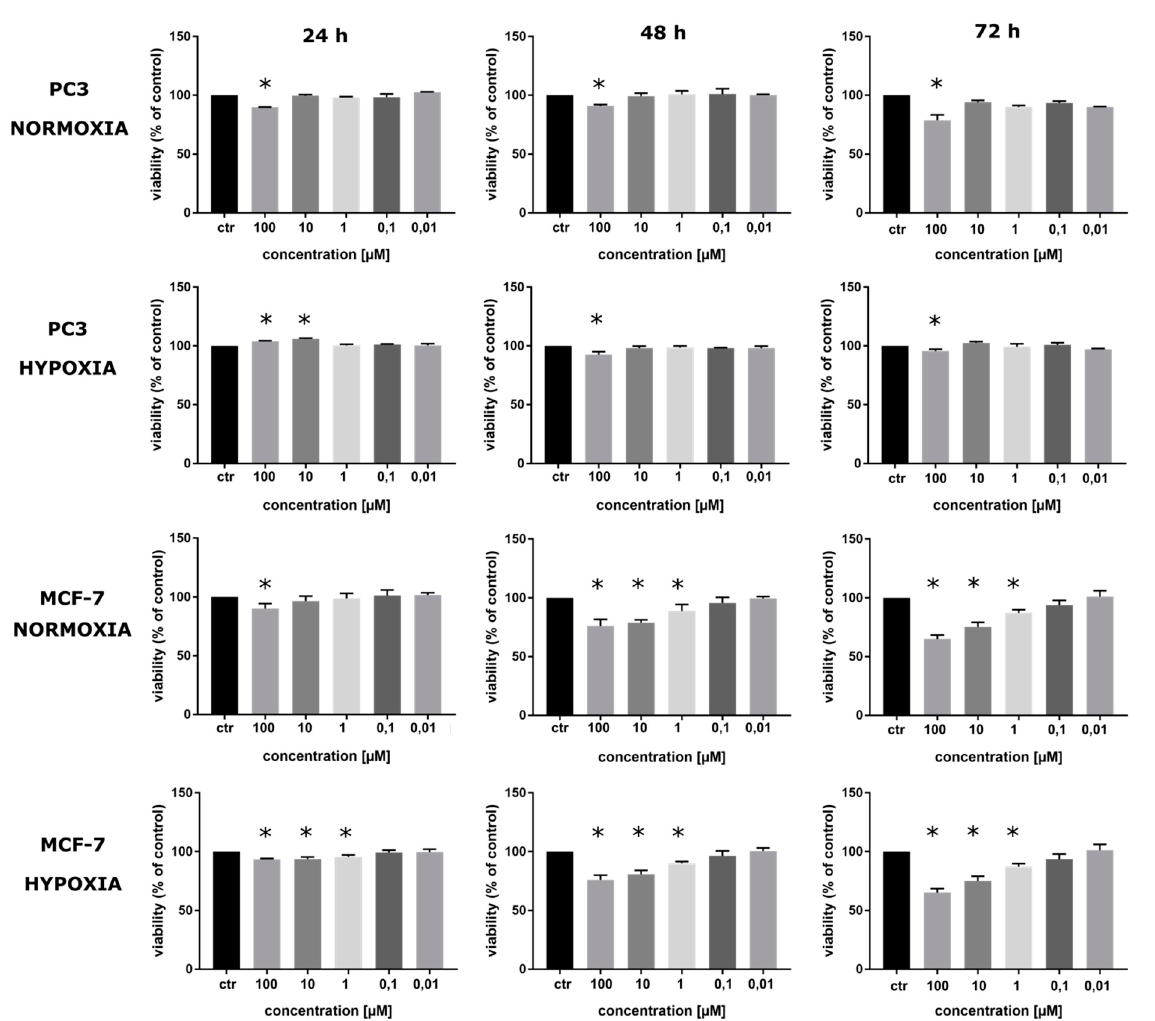
Figure 2. The viability of MCF-7 and PC3 cells after 24, 48 and 72 h treatment with BrdU in a range of concentrations from 0 to 100 µM under hypoxic and normoxic conditions. Results are shown